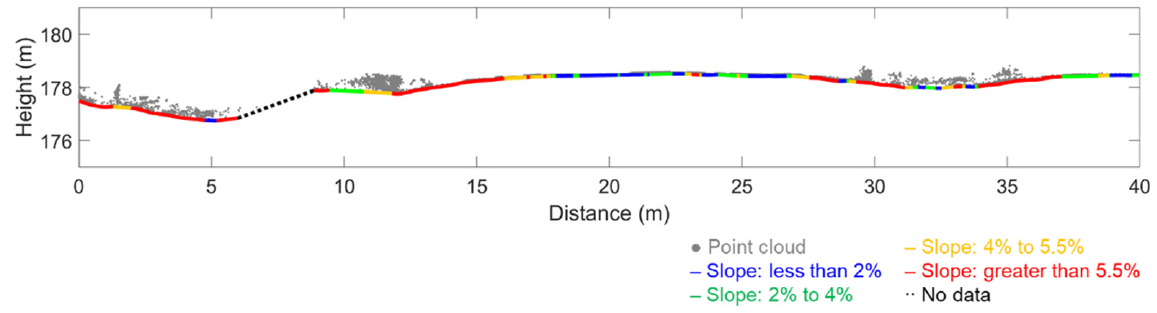
Figure 7. An example of cross-sectional profile colored by slope.